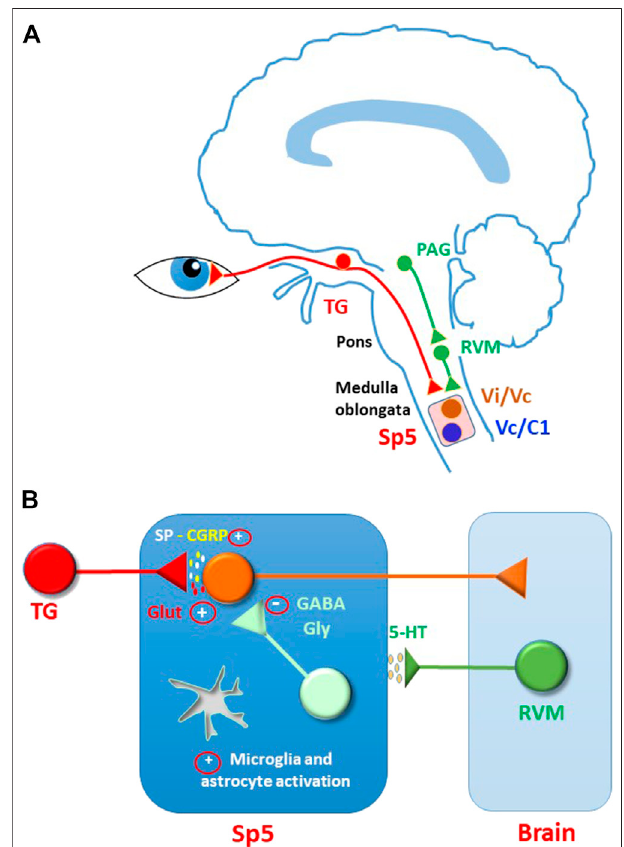
FIGURE 2 | Modulation and sensitization of sensory input in the spinal trigeminal nucleus (Sp5). (A) Corneal sensory input is processed in Sp5, mainly at the transition between the subnuclei interpolaris and caudalis (Vi/Vc) and at the junction between the subnucleus caudalis and the upper cervical spinal cord (Vc/C1). Sp5 activity is controlled by descending modulation, comprising serotoninergic pathways. Serotoninergic neurons are located in rostral ventral medulla (RVM) and are activated by projection neurons in periaqueductal grey area (PAG). (B) Hypothetical mechanisms sustaining central ocular pain sensitization in Sp5. Persistent corneal nociceptive input may induce a general increase of synaptic excitation (mostly mediated by glutamate and peptides) and a decrease of synaptic inhibition (mediated by GABA and glycine). As reported for several forms of spinal and trigeminal pain, glutamate receptors could be potentiated by increased phosphorylation and participate to plasticity phenomena, such as wind-up and LTP. Synaptic inhibition could be depressed through changes of chloride equilibrium potential, LTD, neuronal loss, decrease of transmitter release, and presynaptic facilitation. Furthermore, a switch in the function of serotoninergic modulation from anti-to pro-nociceptive could contribute to the hyperexcitability state. Further studies are needed to con fi rm these mechanisms in the ocular pain